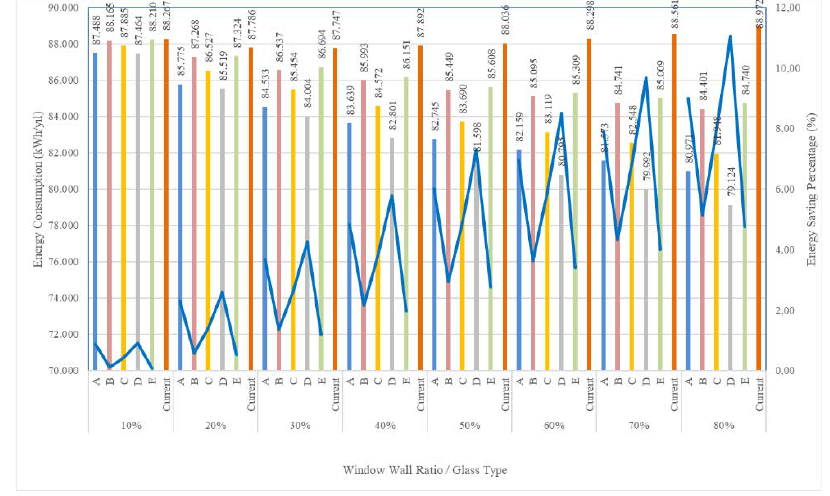
Figure 12 Energy saving rates, calculated energy consumptions and reference energy consumptions for Southwest